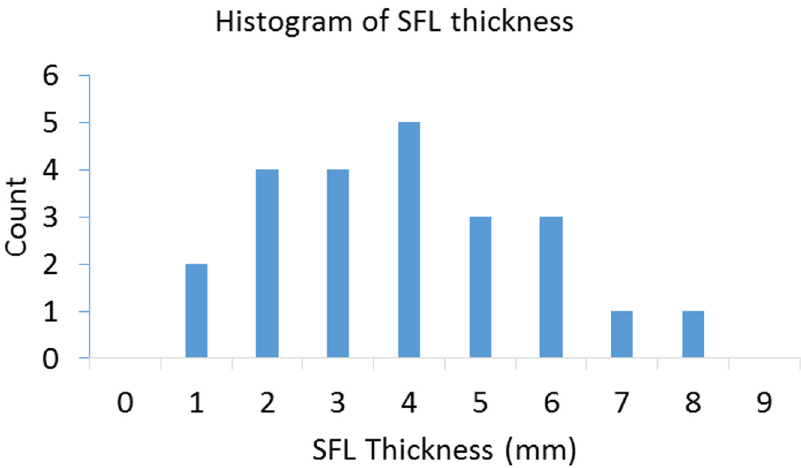
Fig 3. Histogram showing the distribution of measured SFL thickness overlying the biceps in the recruited 23 healthy subjects.